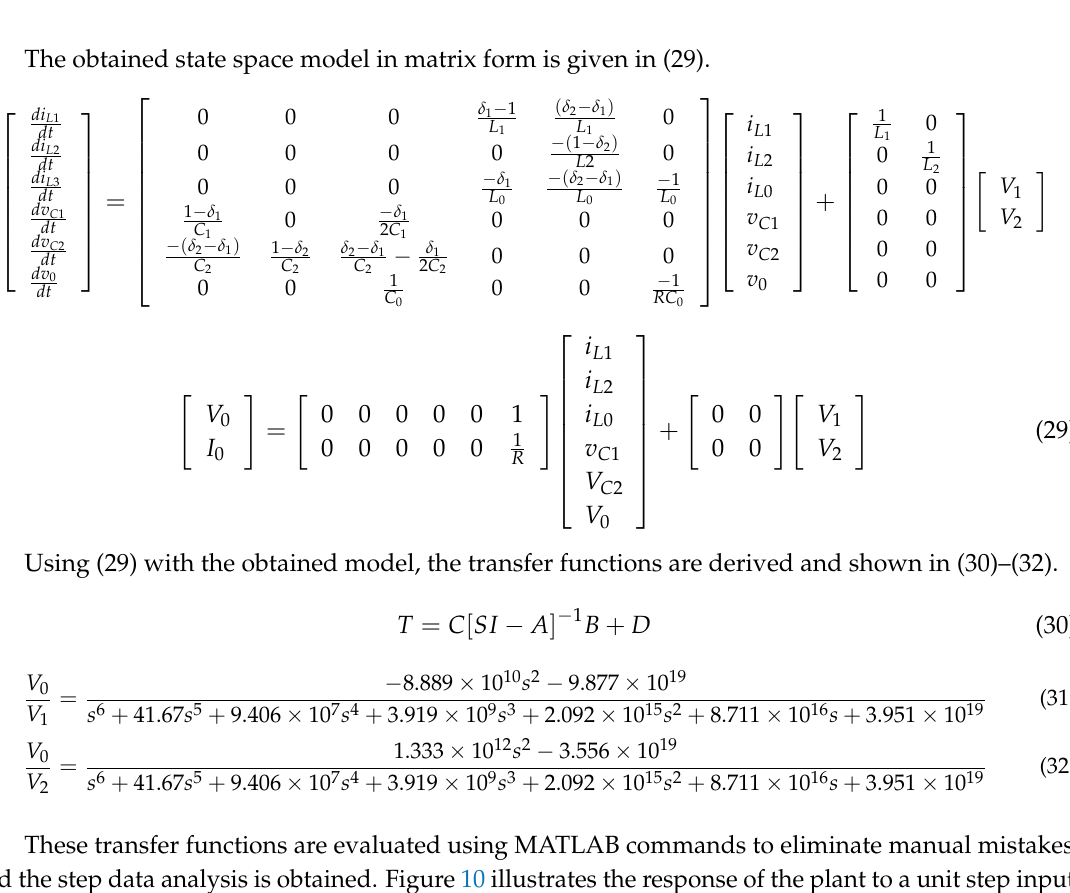
1 source and ( b ) with V 2